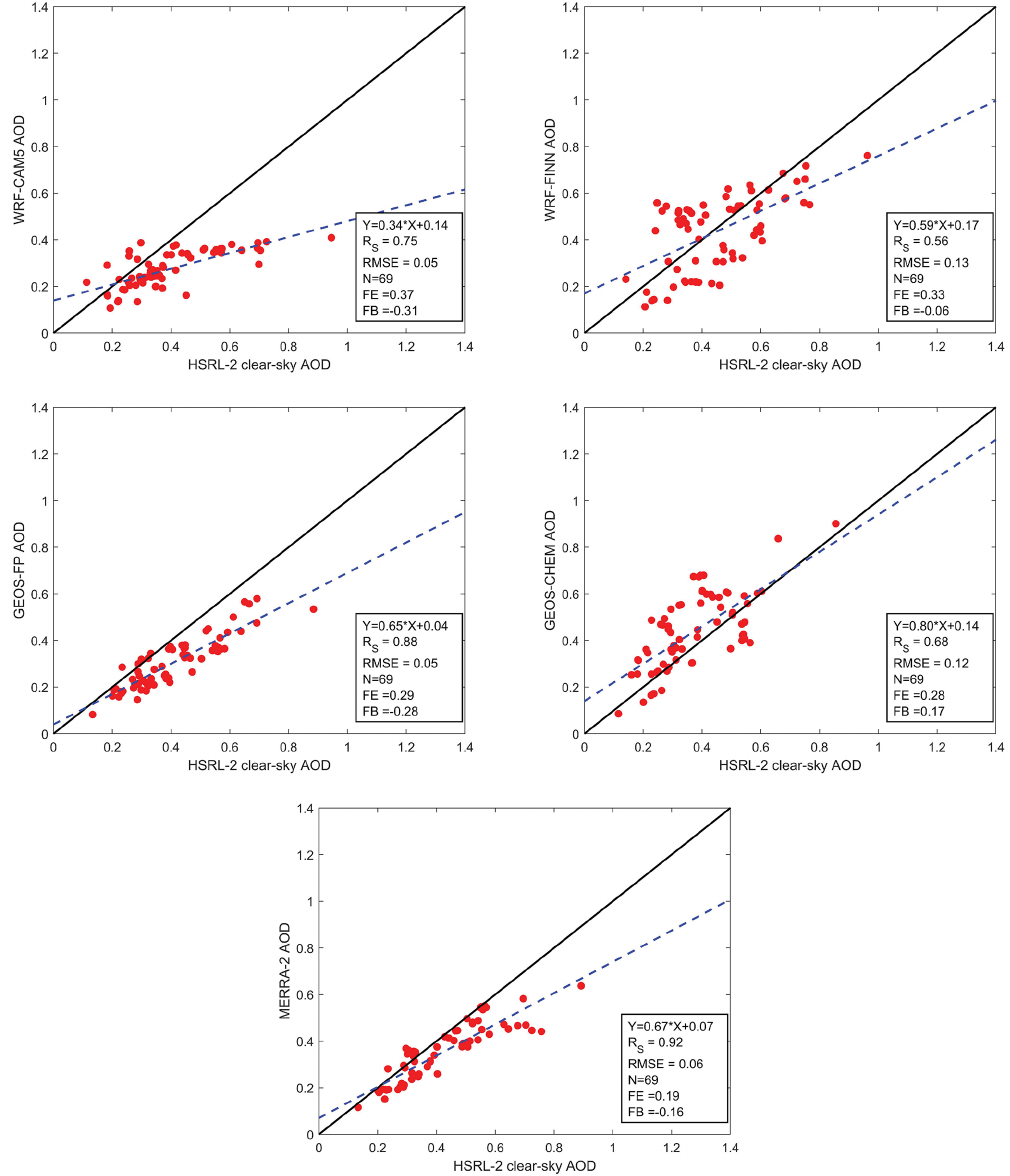
Figure 12. Scatterplots comparing full-column AOD (at 550nm) among models and HSRL-2 clear-sky AOD during August 2017 of the ORACLES field